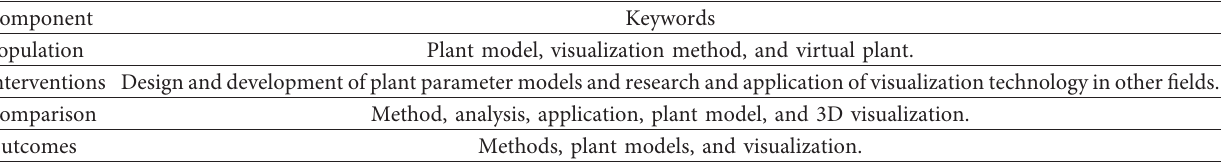
Table 3: Extracted keywords from our PICO